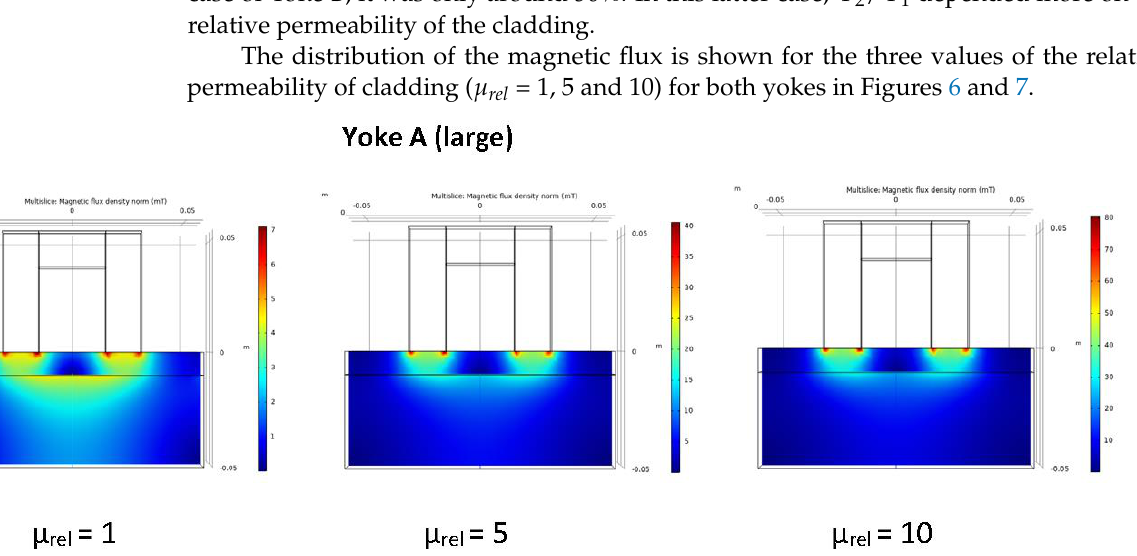
Figure 6. Distribution of the calculated flux density in the cladded block for three values of relative permeability of the cladding if the large magnetizing yoke (Yoke A) is applied.